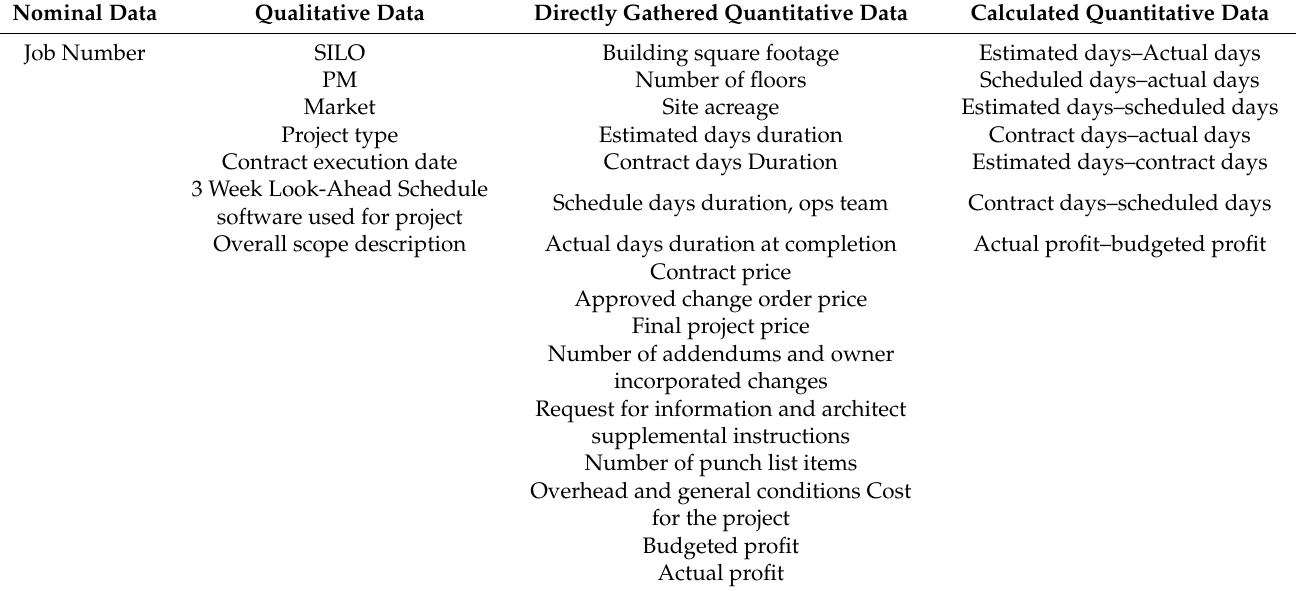
Table 1. Project data factors sorted by